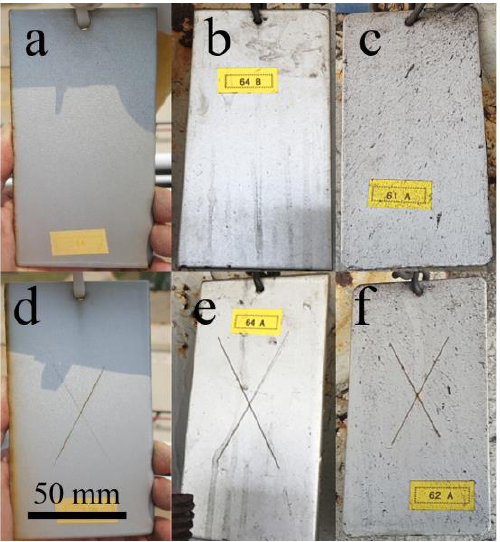
Figure 1. Protective effect of different coatings after 1 year of coupon corrosion test: ( a ) modified nanoscale titania coating, ( b ) graphene coating, ( c ) metal flake coating, ( d ) coating ( a ) with X, ( e ) coating ( b ) with X, ( f ) coating ( c ) with X.